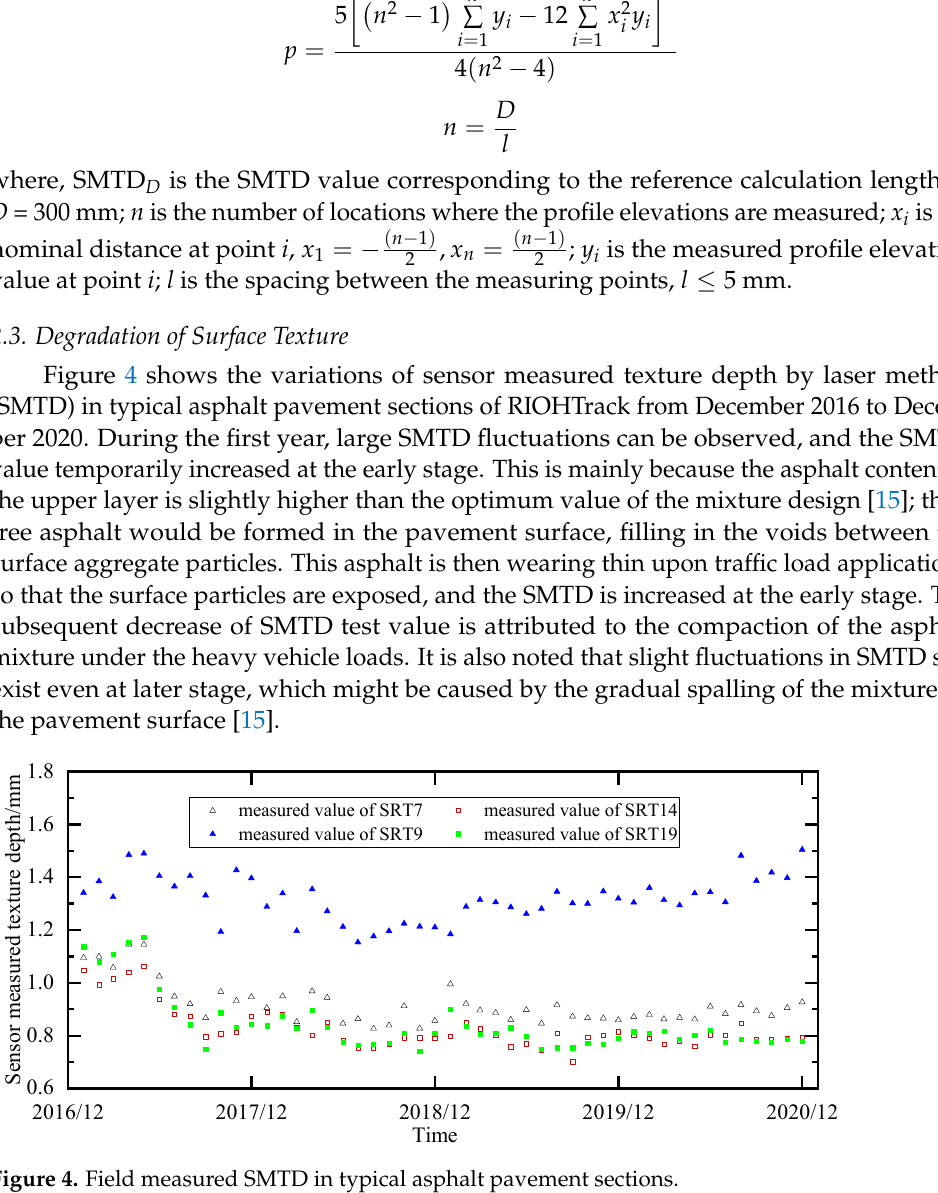
Figure 4. Field measured SMTD in typical asphalt pavement sections.